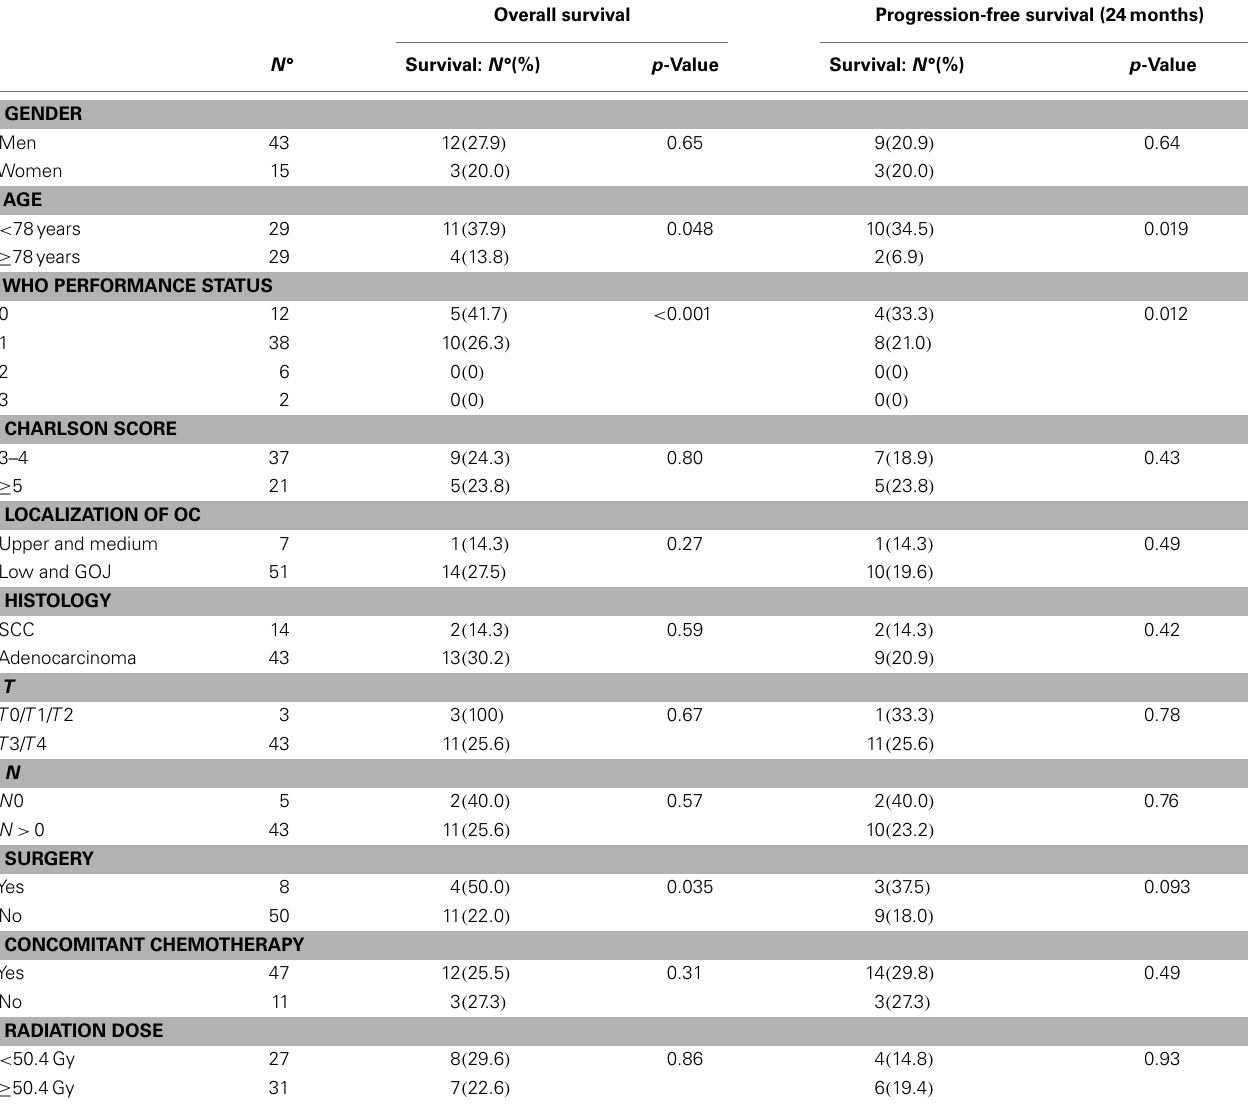
Table 3 | Univariate analysis for overall and progression-free survival in population treated in a curative intent . Overall